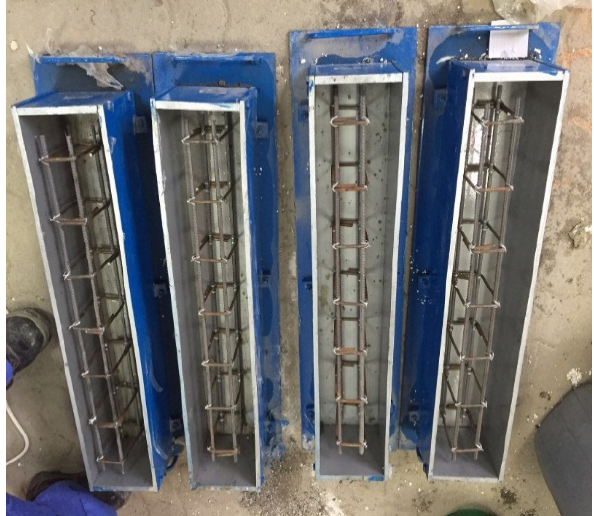
Figure 3: Reinforcement cage.